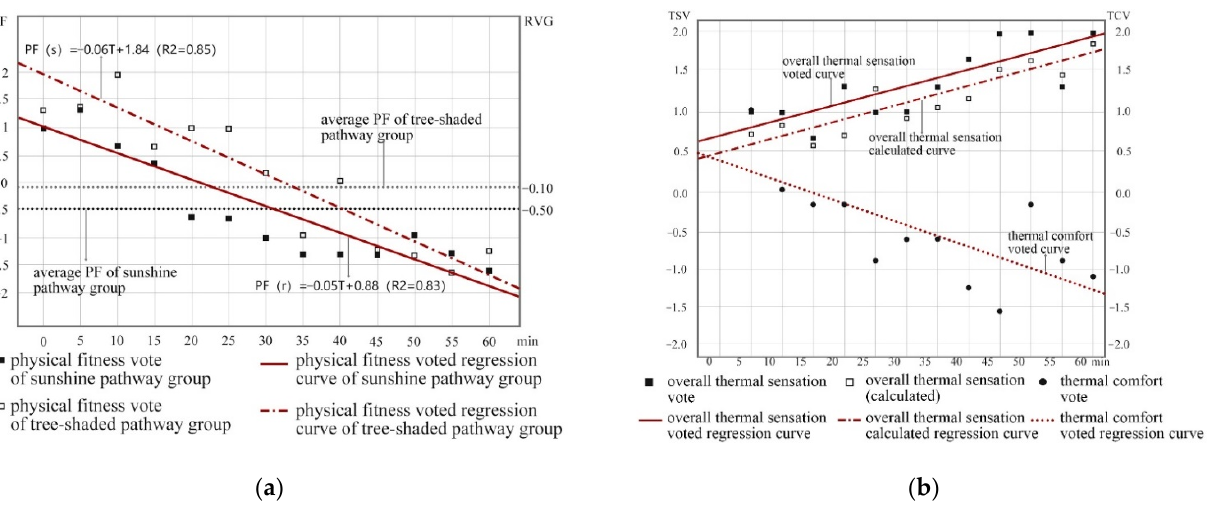
Figure 9. ( a ) Voted overall thermal sensation, calculated overall thermal sensation, and thermal comfort of tree-shaded pathway group. ( b ) Voted overall thermal sensation, calculated overall thermal sensation, and thermal comfort of sunshine pathway. Voted overall thermal sensation, calculated overall thermal sensation, and voted thermal comfort of tree-shaded pathway group and sunshine pathway group.